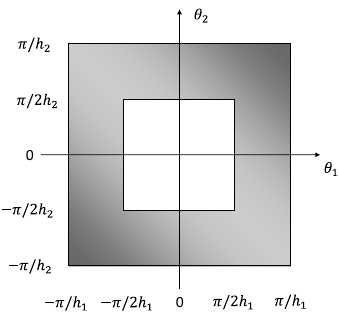
Figure 3. High (shaded region) and low (white region) frequencies for standard